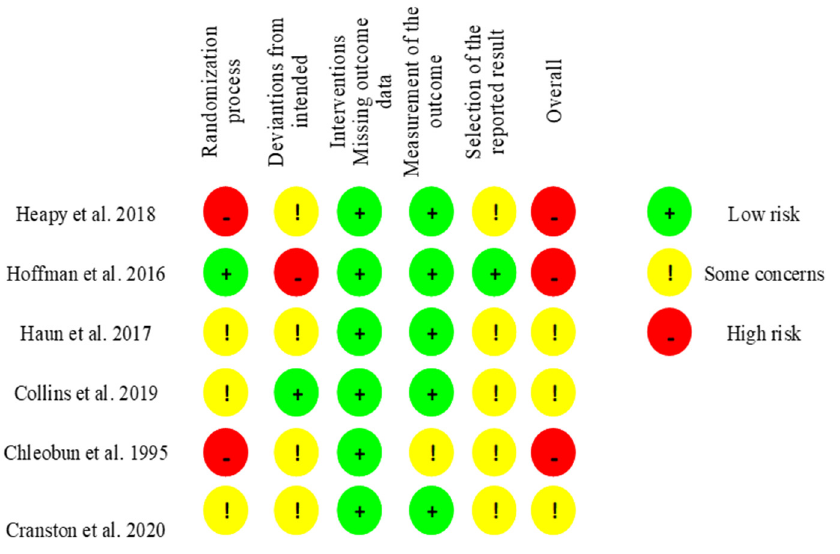
Figure 1. Risk of bias 2 tool. Assessment for individual randomized, parallel-group trials [25].